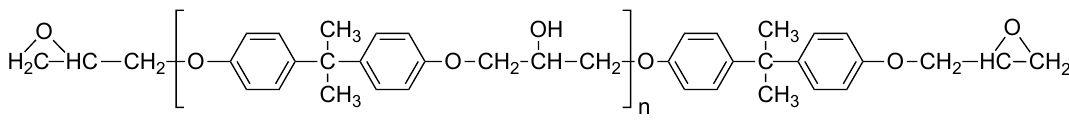
Figure 3. Structure of resin based on on Bisphenol-A diglycidyl